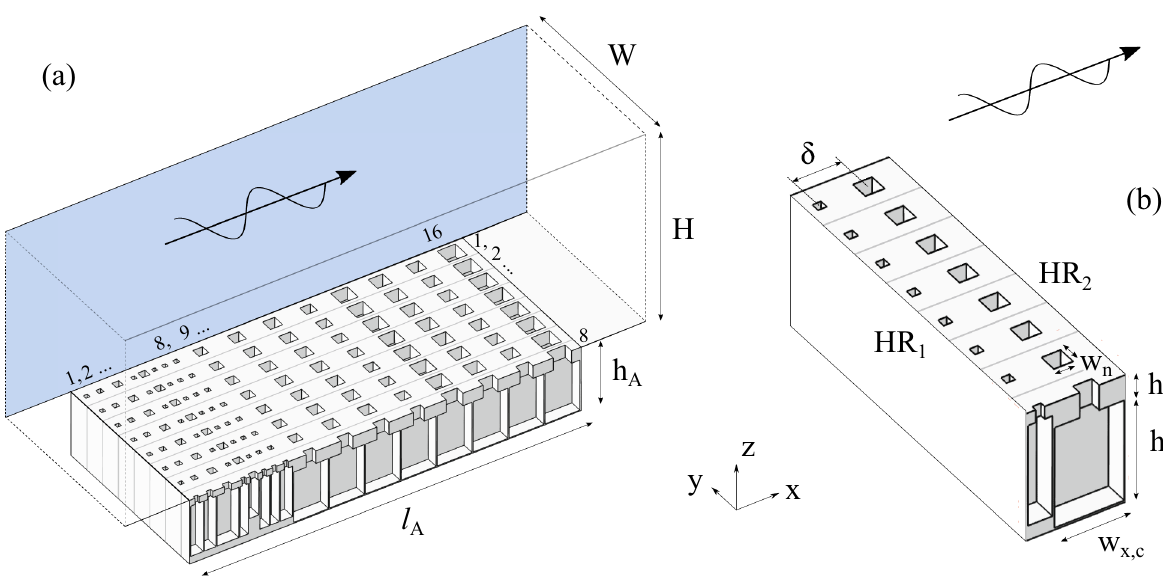
H 14.8 15 cm 2 duct. The incident sound × = ×